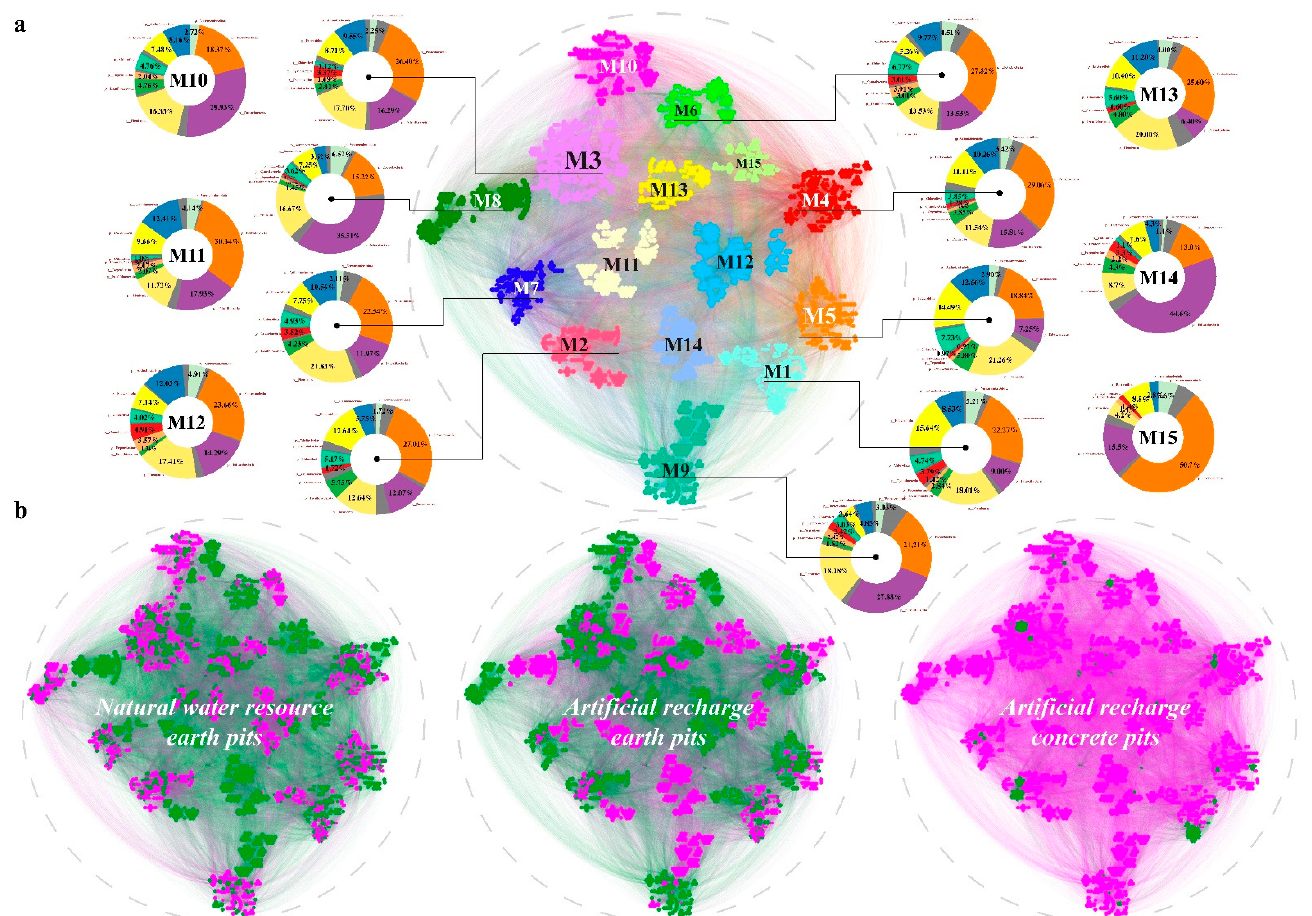
Figure 4. Microbial co-occurrence total network. ( a ) Layout and taxonomic profiles of 15 dominant modules (M) in the microbial co-occurrence network. Modules are displayed in different colors. ( b ) The distribution of vertices from 3 subnetworks, where green indicates the vertices from corresponding subnetworks.